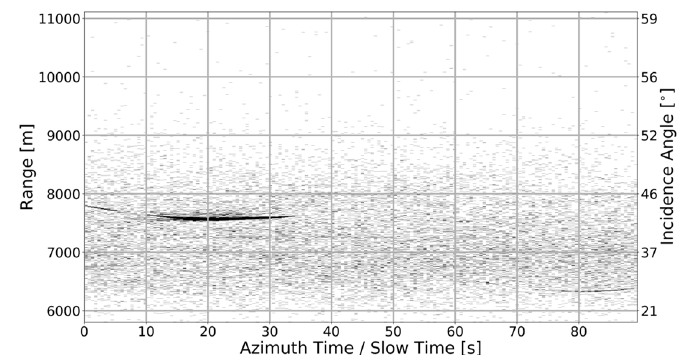
Figure 18. Binary detection map based on the K-distribution obtained from the same RC F-SAR X-band HH polarized data shown in Figure 10. The detected ship signal (left) and high sea clutter spikes can be clearly observed.